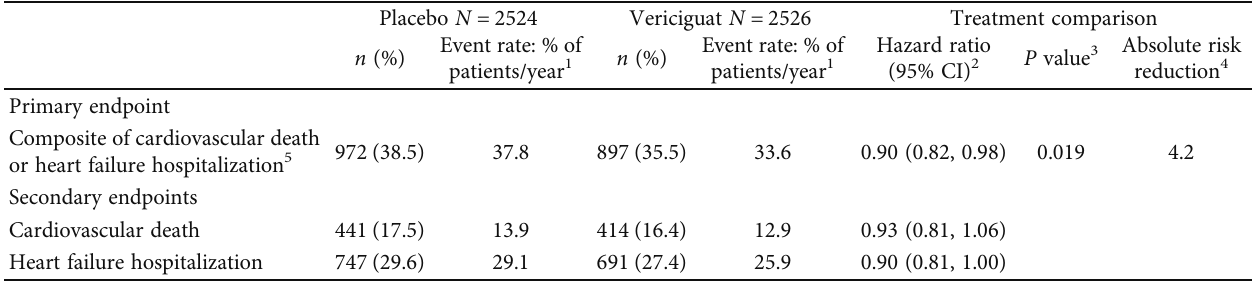
Table 1: Treatment e ff ect for the primary composite endpoint and the secondary endpoints of cardiovascular death and heart failure